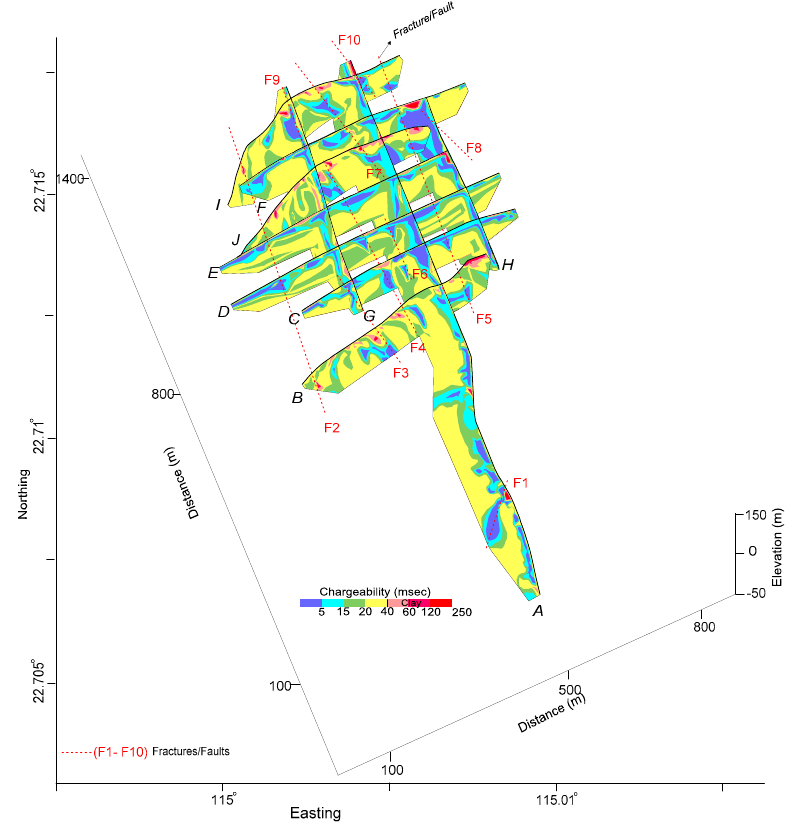
Figure 5. Integration of 10 2D IP models along all profiles (with IP increasing from blue to red on a color bar) interpreted for the clay (shown by red color), and fractures/faults (dotted reds lines).